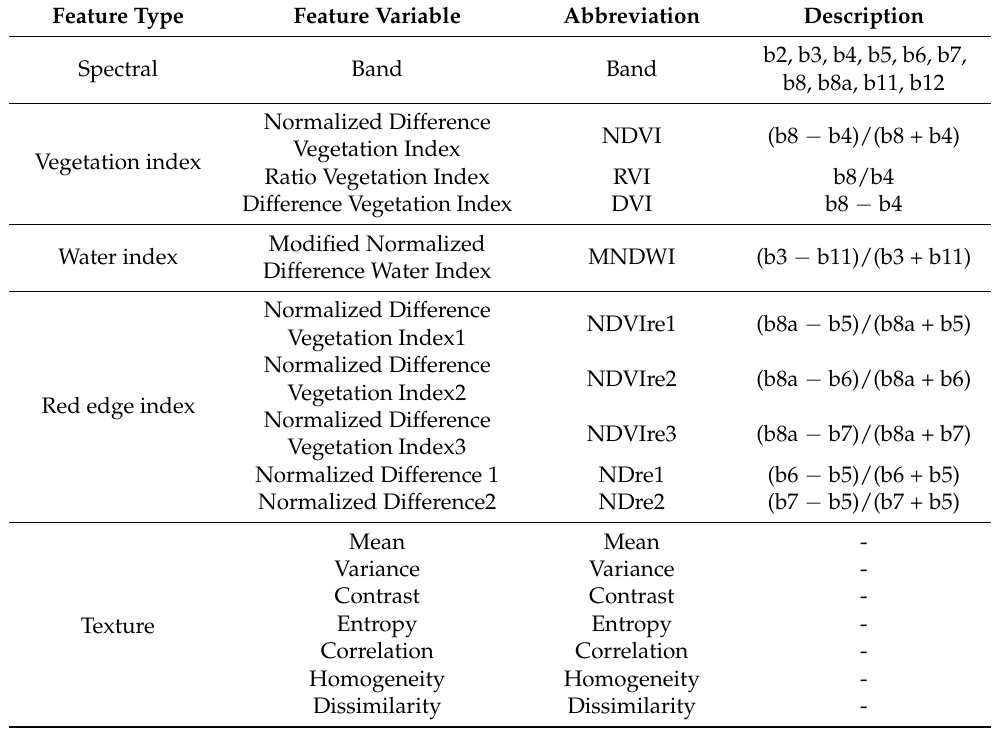
Table 2. Sentinel data feature-type selection.